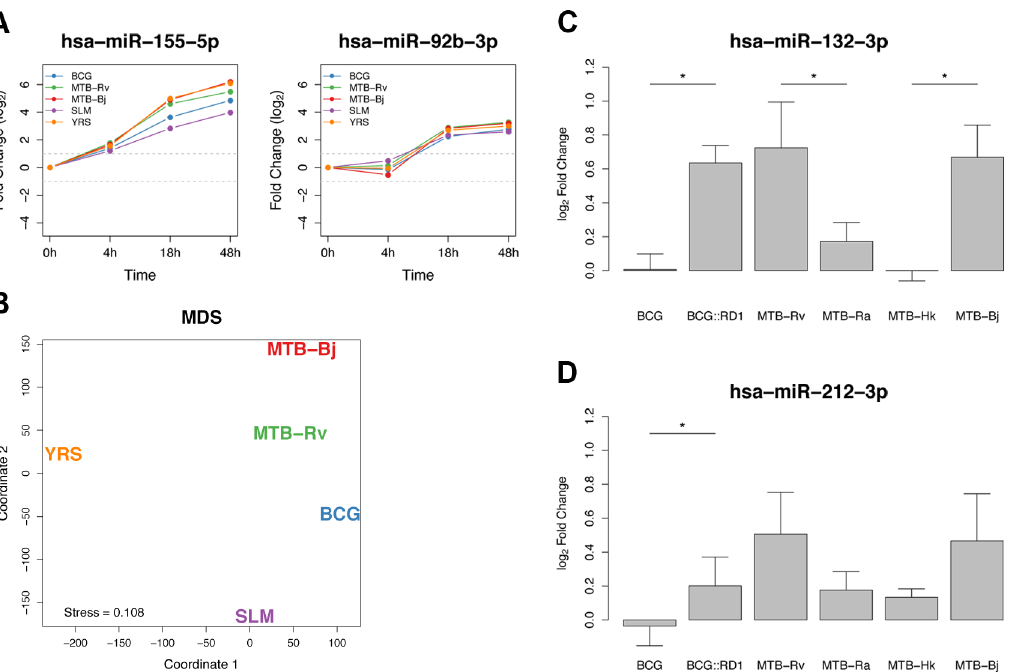
Fig 2. Shared and specific miRNA responses to bacterial infection. (A) Plots of the temporal dynamics of two core response miRNAs. As we did not have expression profiles for the 48h time point for STP infection, this bacterium was excluded from the analysis. (B) Multidimensional scaling analysis (MDS) representing the distances between the temporal miRNA responses to different bacterial infections. Distances were based on the sum of edit distances, for each miRNA, between bacteria using STEM-assigned model temporal profiles. (C) The expression of miR-132-3p increased following infection with MTB-Rv and MTB-Bj but not BCG. Transformation of BCG with RD1 from MTB resulted in a significant increase in miR-132-3p expression, not significantly different to that induced by MTB-Rv. Both MTB-Ra and MTB-Hk showed significantly lower miR-132-3p expression than virulent mycobacteria. (D) The induction of miR- 212-3p was significantly higher following BCG::RD1 infection, compared to infection with control BCG, and was not significantly different to the response to MTB-Rv. Though the difference between the induction of this miRNA upon infection with virulent or avirulent MTB strains was not significant, the tendencies observed were consistent with miR-132-3p. Significance was calculated using a Mann-Whitney test ( * = p < 0.05).